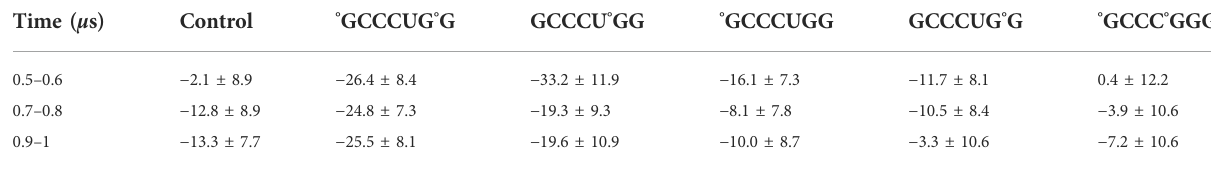
TABLE 1 Average and standard deviations (in kcal/mol) of the binding energy of the RNA fragment GCCCUGG to the PCBP1 RNA-binding domain for the different oxidized guanine positions. The values are determined at different times along the 1- μ s trajectories. Time ( μ s) Control ° GCCCUG ° G GCCCU ° GG ° GCCCUGG GCCCUG °